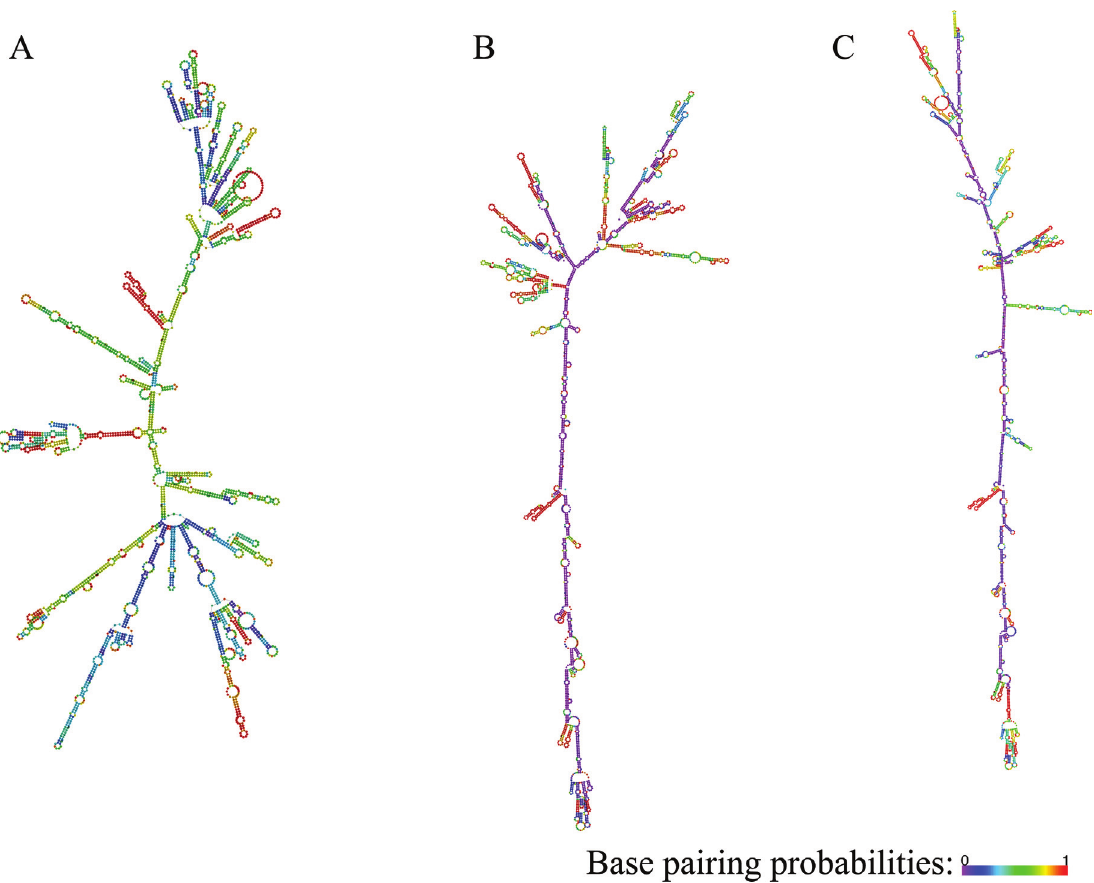
Figure 3 - Folding patterns of SQSTM1 transcript variants. A - transcript variant 1; B - transcript variant 2; C - transcript variant 3. Color-scale represents base pairing probabilities: violet and red correspond to 0 and 1 probabilities,